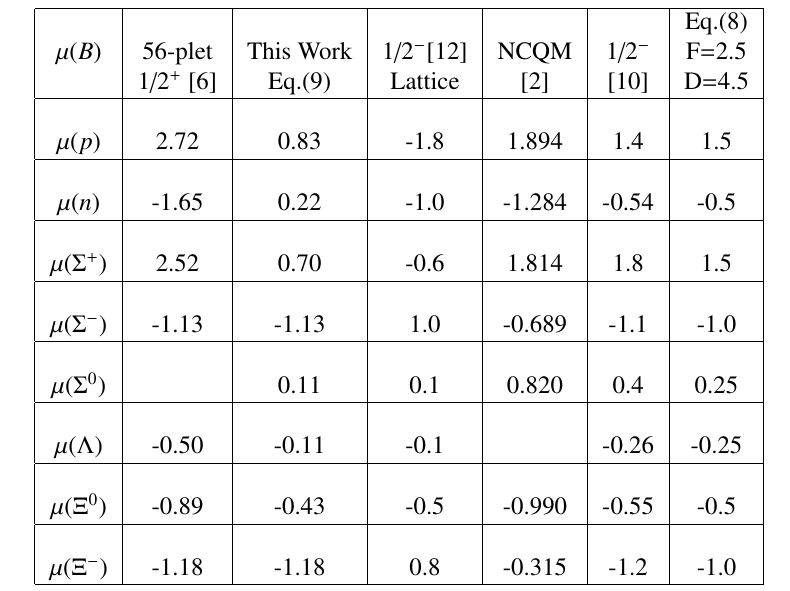
Table 1. Magnetic moments of 70-plet and 56-plet 1 / 2 ± baryons